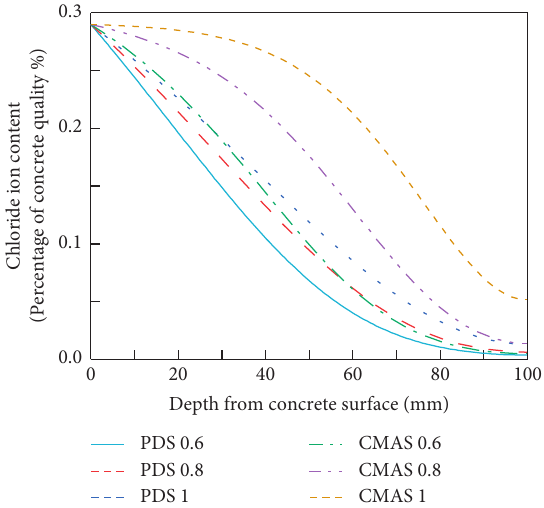
Figure 11: Chloride content distribution under diffusion in moisture absorption.